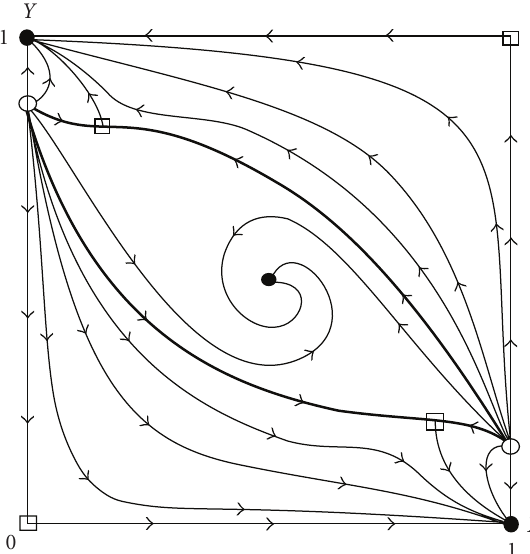
Figure 5.1 . Two interior saddles and one interior attractor, whose basin is bounded by the union of the saddles stable manifolds.